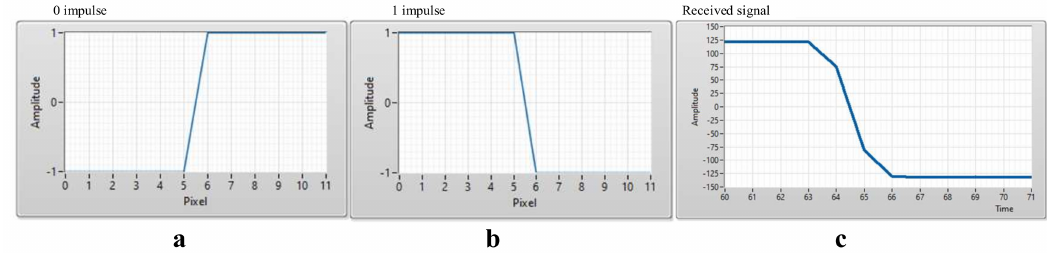
Figure 4. Manchester code signal patterns and COOK received signal. ( a ) 0 impulse, ( b ) 1 impulse, ( c ) COOK received